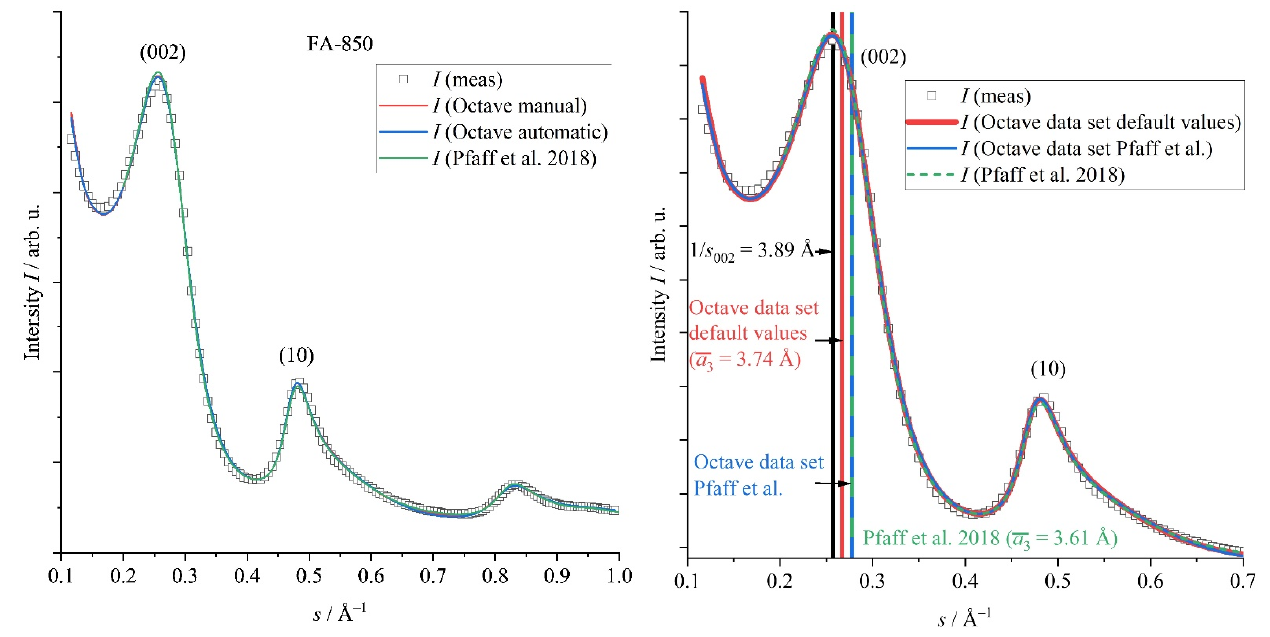
Figure 6. Validation of OctCarb using WAXS data of FA-850 (furfuryl alcohol-based carbon). Auto- matic refinements using different starting parameters were performed in order to analyze the impact of the initial values on the final fitting result during the non-linear fitting procedures. Green : Final refinement of Pfaff et al. [25]: red: automatic fitting by OctCarb using the refined microstructural values from Pfaff et al. [25] as initial parameters ( Octave data set Pfaff et al. see Figure S1), blue: automatic fit with our default starting parameters as described in the SI File (part A) in Table S7 ( Octave data set default values , see Figure S1). A first analysis using the already refined microstructure parameters from Pfaff et al. [25] served to validate if the general refinement works in principle and leads to comparable results. The second analysis using the default starting parameters aimed to validate if the numerical refinement/minimalization of OctCarb works well and leads to the same (or similar) results. These default starting values are in principle means of the aforementioned struc- tural parameters of common NGCs. Additionally, in this study and in the model of Ruland and Smarsly [44], a 3 (cid:3365) is defined as the mean value of the layer distances, whereas calculating the average layer distance by 1/ s (002) does not provide a mean, but the modal value. Therefore, these values are different, and in conclusion, an average layer distance a 3 (cid:3365) (mean) can only be calculated by a refine- ment of the whole (002) reflection and not only from the position of the maximum. Note: only every second measurement point is shown for better visibility. For plots of the other samples, see Figure S1 in the SI File (part A).